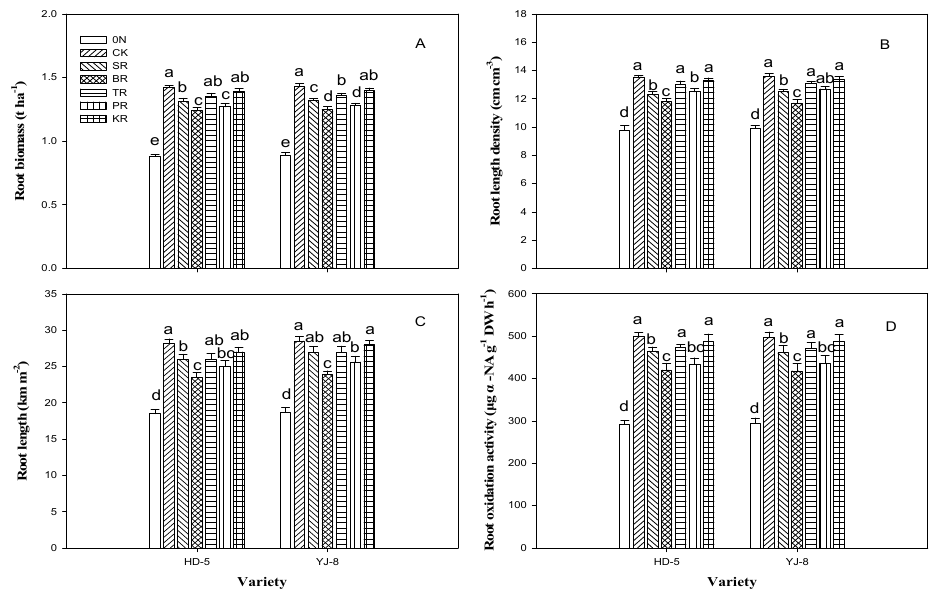
Figure 2. Root biomass ( A ), root length density ( B ), root length ( C ) and root oxidation activity ( D ) of rice at heading under various N reduction treatments. Vertical bars represent ± standard error of the mean where these exceed the size of the symbol. Different letters above the column indicate statistical significance at the p = 0.05 level.